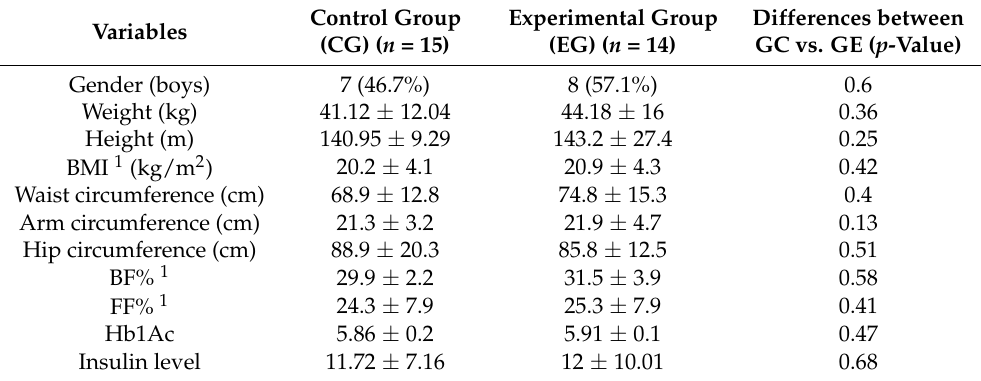
Table 1. The study included anthropometric characteristics of the 29 children with prediabetes according to the randomization group (initial visit (V0)).